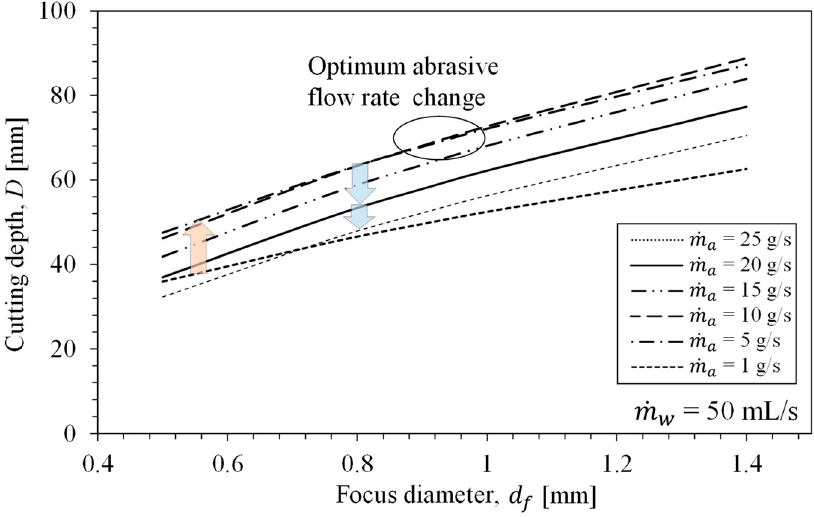
Figure 13. Effects of the focus diameter on the cutting depth owing to the